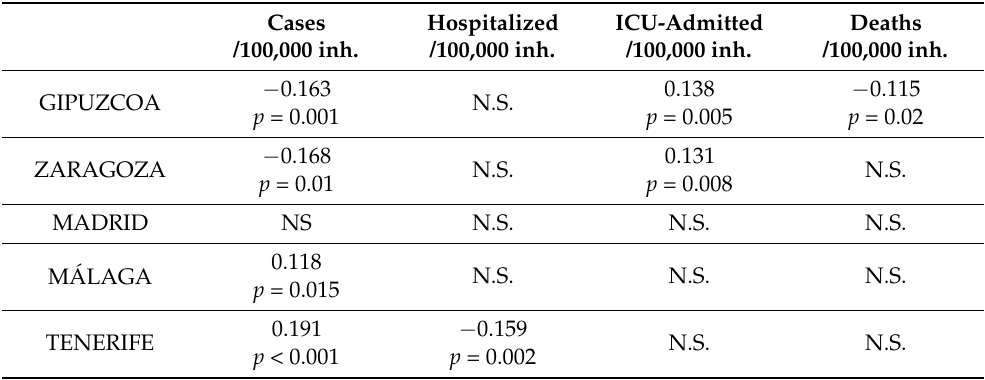
Table 4. Correlations between mean humidity and COVID-19 incidence rate, hospitalized cases, ICU-admitted cases, and deaths per 100,000 inhabitants. Cases /100,000